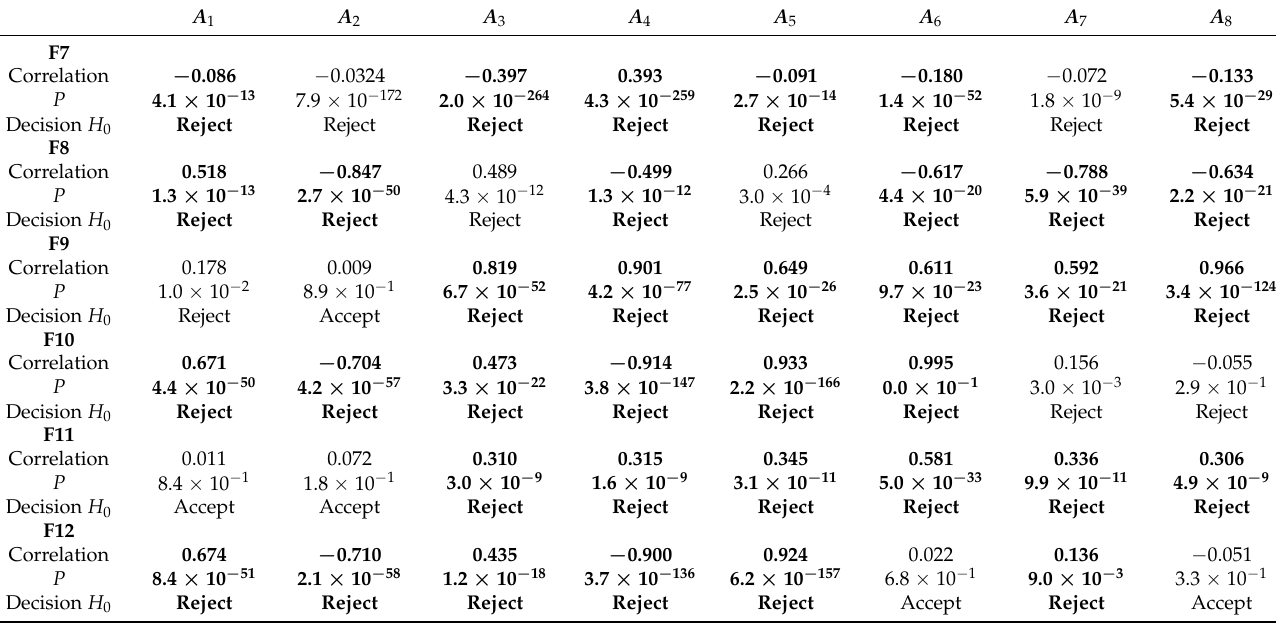
Table 7. Correlation analysis ( ρ ) for 8 sampled attributes for F7–F12.